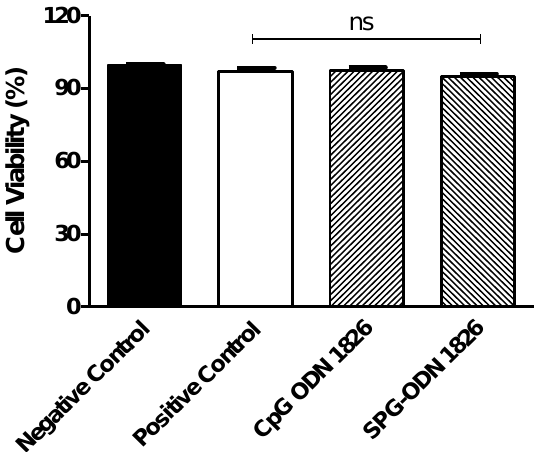
Figure 3. Cell viability of J774A.1 cells treated with different dilutions of synthesized SPG-ODN 1826 nanovehicles for 24 h using an MTT assay. The data presented are the mean ± SEM of three individual experiments, where each was performed in triplicate. Statistical significance between different groups was evaluated using one-way ANOVA where ns (non-significant) indicates p > 0.05.